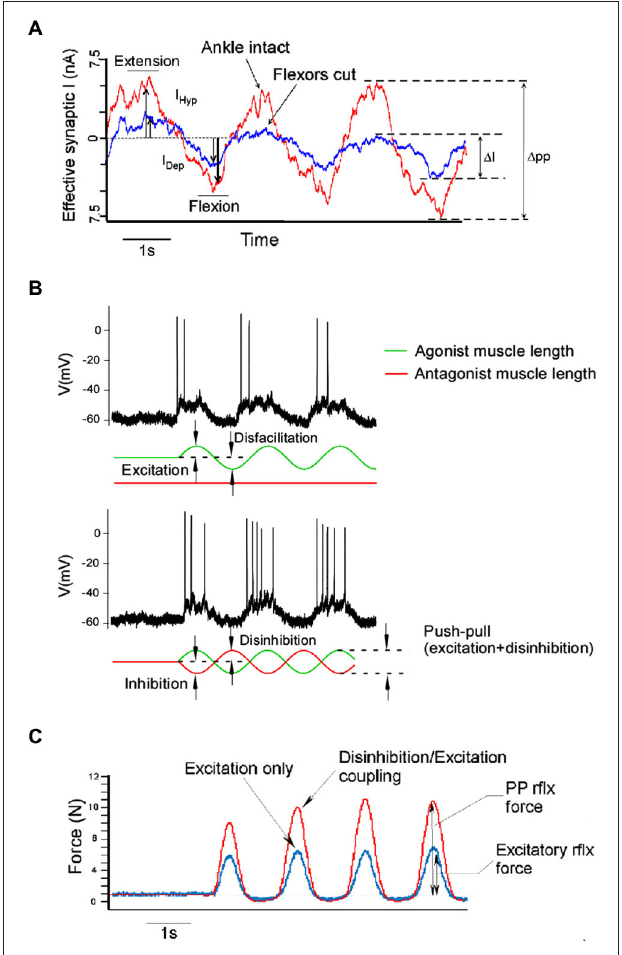
FIGURE 5 | Push-pull effects in vivo . Intracellular currents measured at the voltage clamped motoneuron as linear motors connected to the distal tendon of it’s agonist and antagonist muscles alternately stretch and shorten the muscles show that the push-pull configuration (tendons intact, red trace) results in greater peak to peak current amplitude than in the non-push-pull configuration (flexor tendons cut, blue trace) (A) . The push-pull configuration, where muscles are stretched and shortened in an alternating pattern (lower panel in B ), also results in greater motoneuron firing rates than modulating excitation alone (upper panel in B ). Push-pull effects manifest at the system level as well. Greater muscle force is produced when excitation is coupled with disinhibition (C)